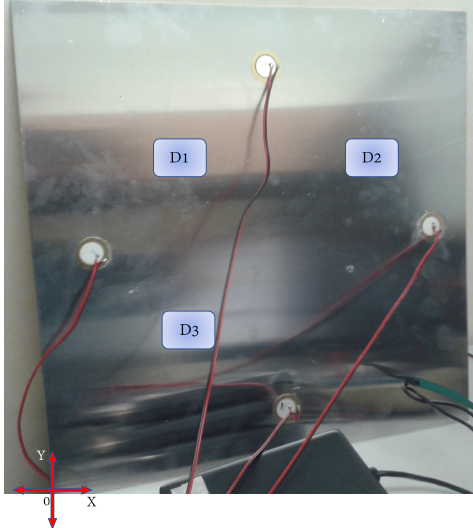
Figure 24. Damage position in the aluminium second specimen plate.